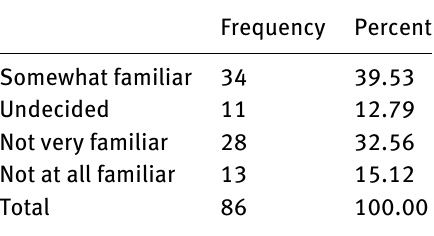
Table 1: Participant Ratings of Robot